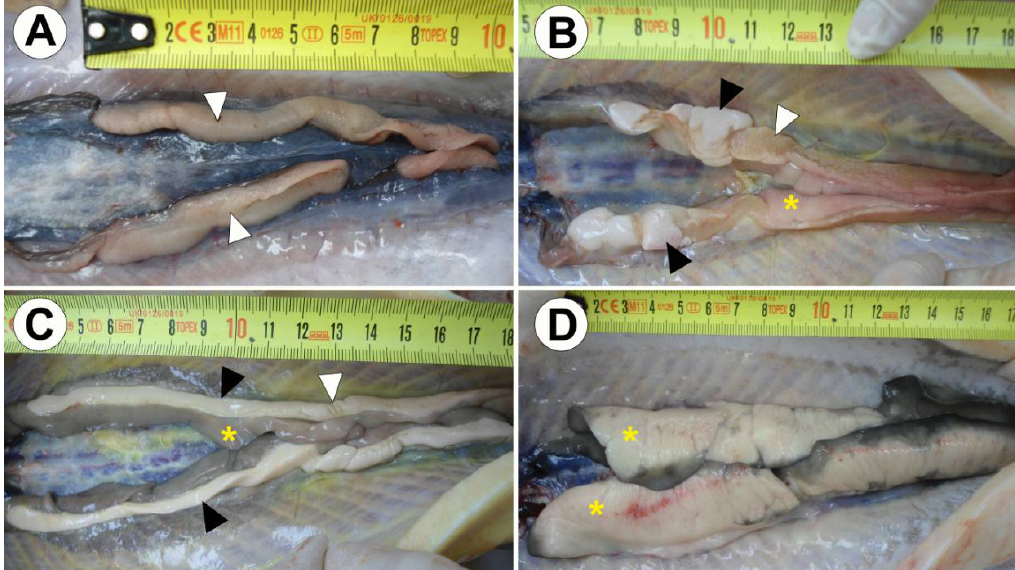
Figure 1. Gonads of 1600th-day-post-hatching (dph) Russian sturgeon. ( A ) Ovary with folded and granular female germinal tissue. ( B ) Ova-testes with a prevailing ovarian component located in the posterior part of the gonad, and testicular component located in the anterior part of the gonad. ( C ) Testes-ova with a prevailing testicular component and an ovarian component scattered apically along the gonad surface. ( D ) Ovary with abundant, white and locally pigmented fat tissue (presence of the germinal tissue on the surface of gonadal folds was only possible to assess by microscopic analyses). Ovarian germinal tissue (white arrowheads), testicular germinal tissue (black arrowheads) and fat (yellow stars).